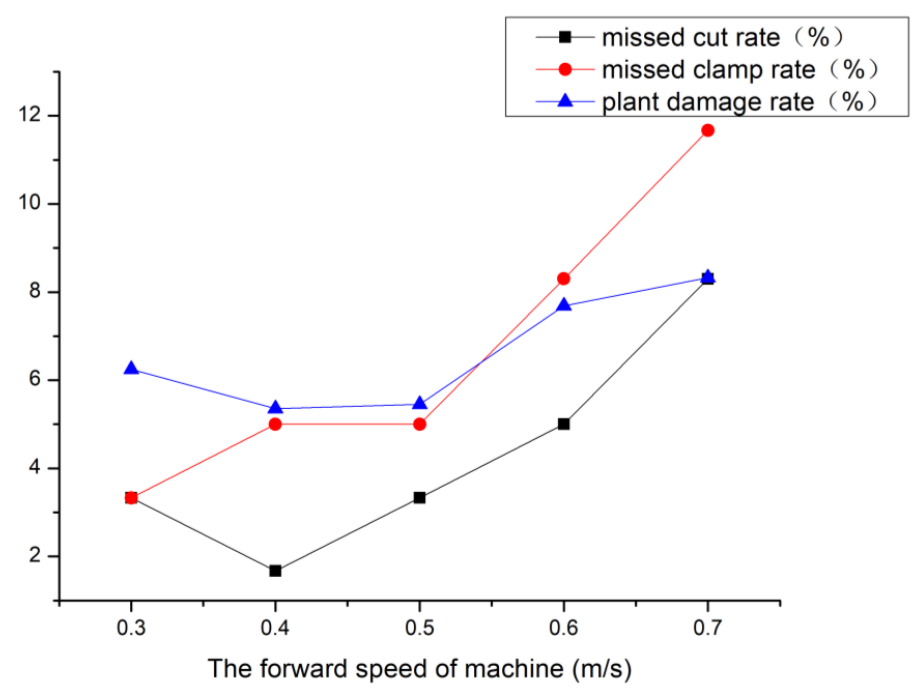
Figure 13. Influence of machine forward speed on harvesting performance.